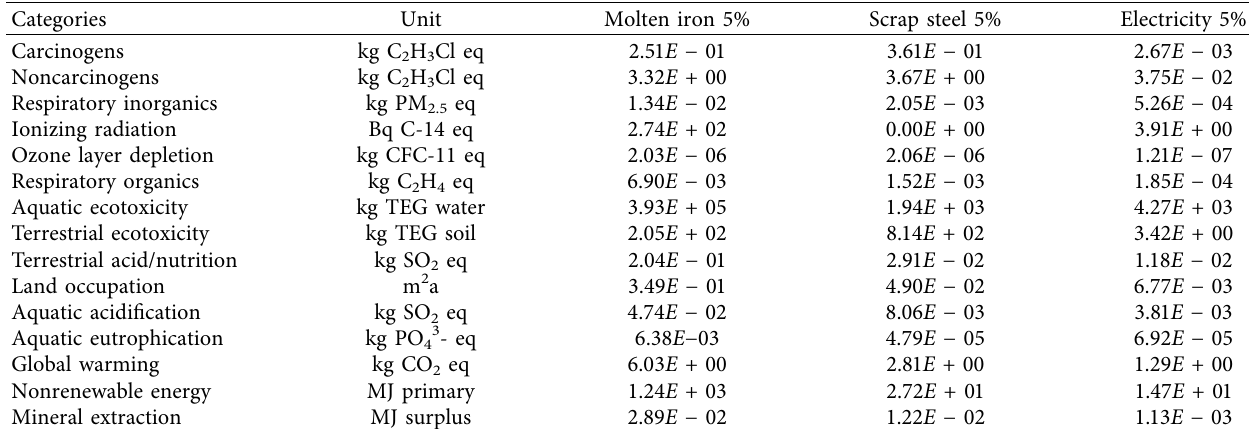
Figure 5: Contributions of the most significant substances to key categories. (a) Human health, (b) ecosystem quality, (c) climate change, and (d) resource. Table 4: Sensitivity